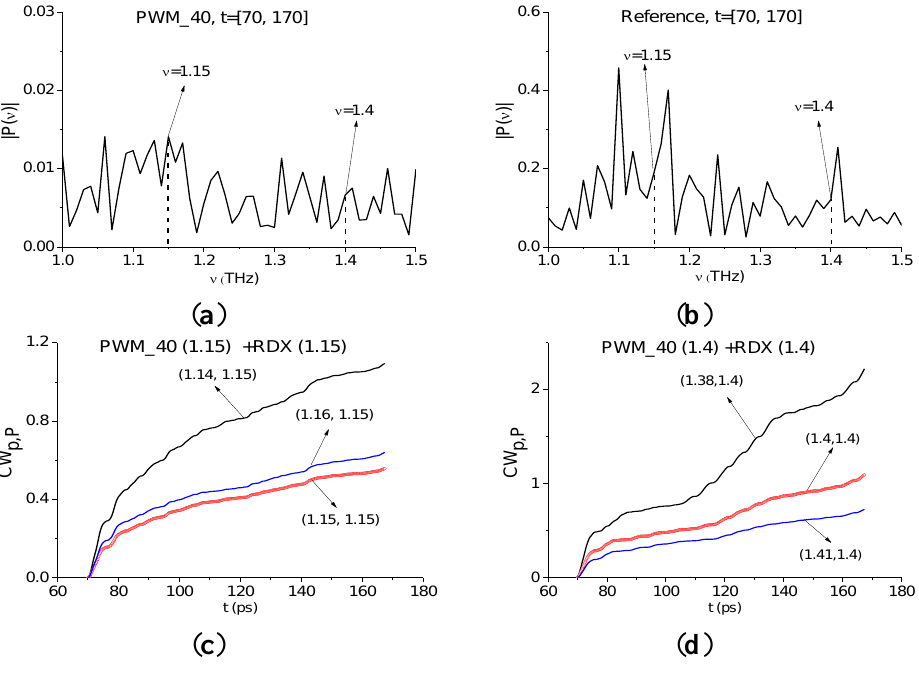
Figure 20. Fourier spectra of the remote part of the signal PWM_40 ( a ); Reference ( b ); integral characteristics CW p , P ( t n ) detecting the frequencies ν = 1.15 THz ( c ); ν =1.4 THz ( d ).